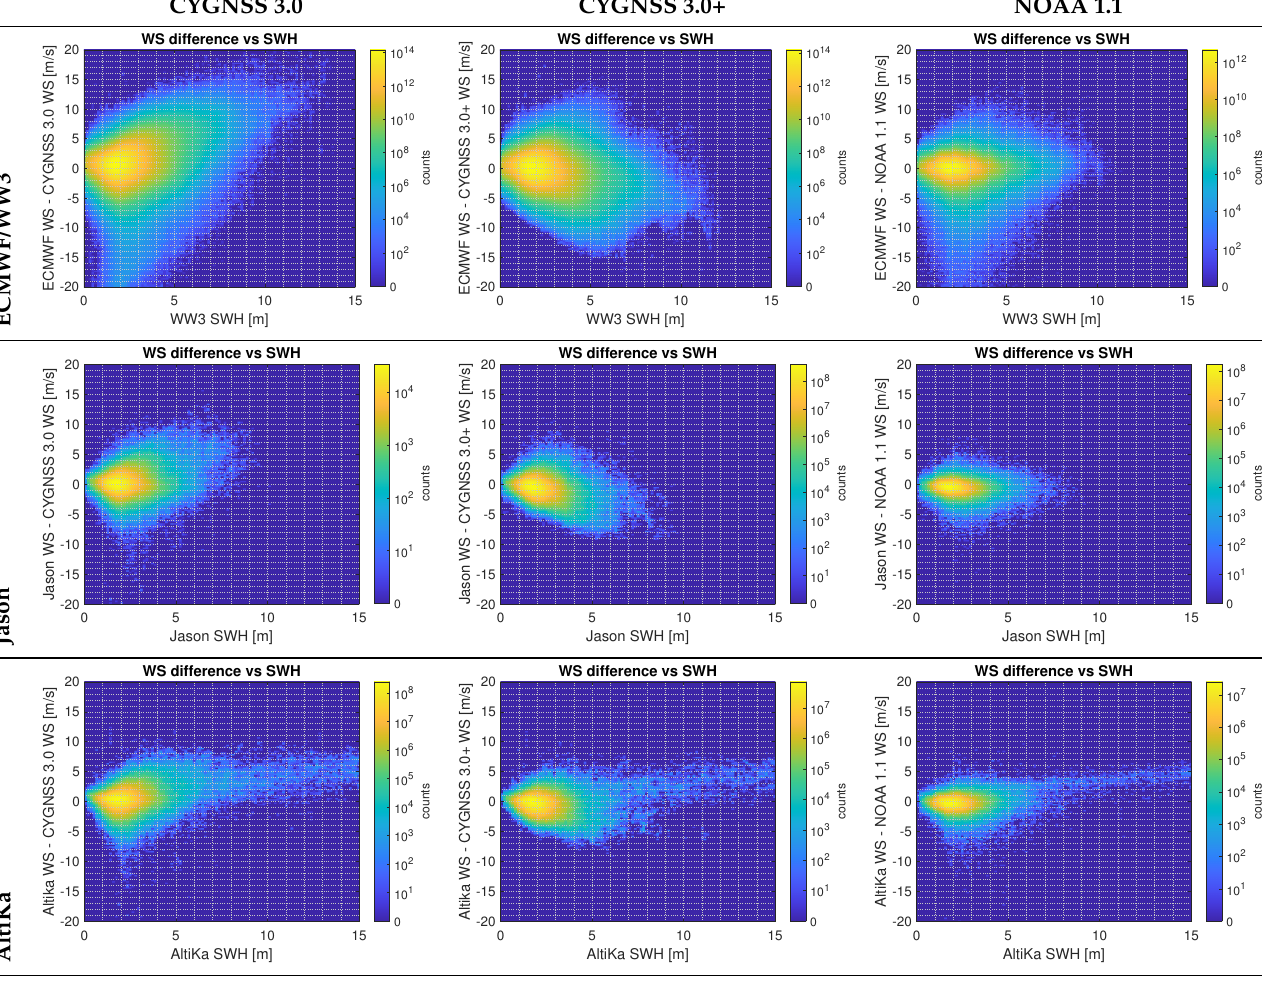
Figure 8. Histograms of the difference between different CYGNSS wind estimates (columns) and different reference winds (rows) vs the SWH given by the same